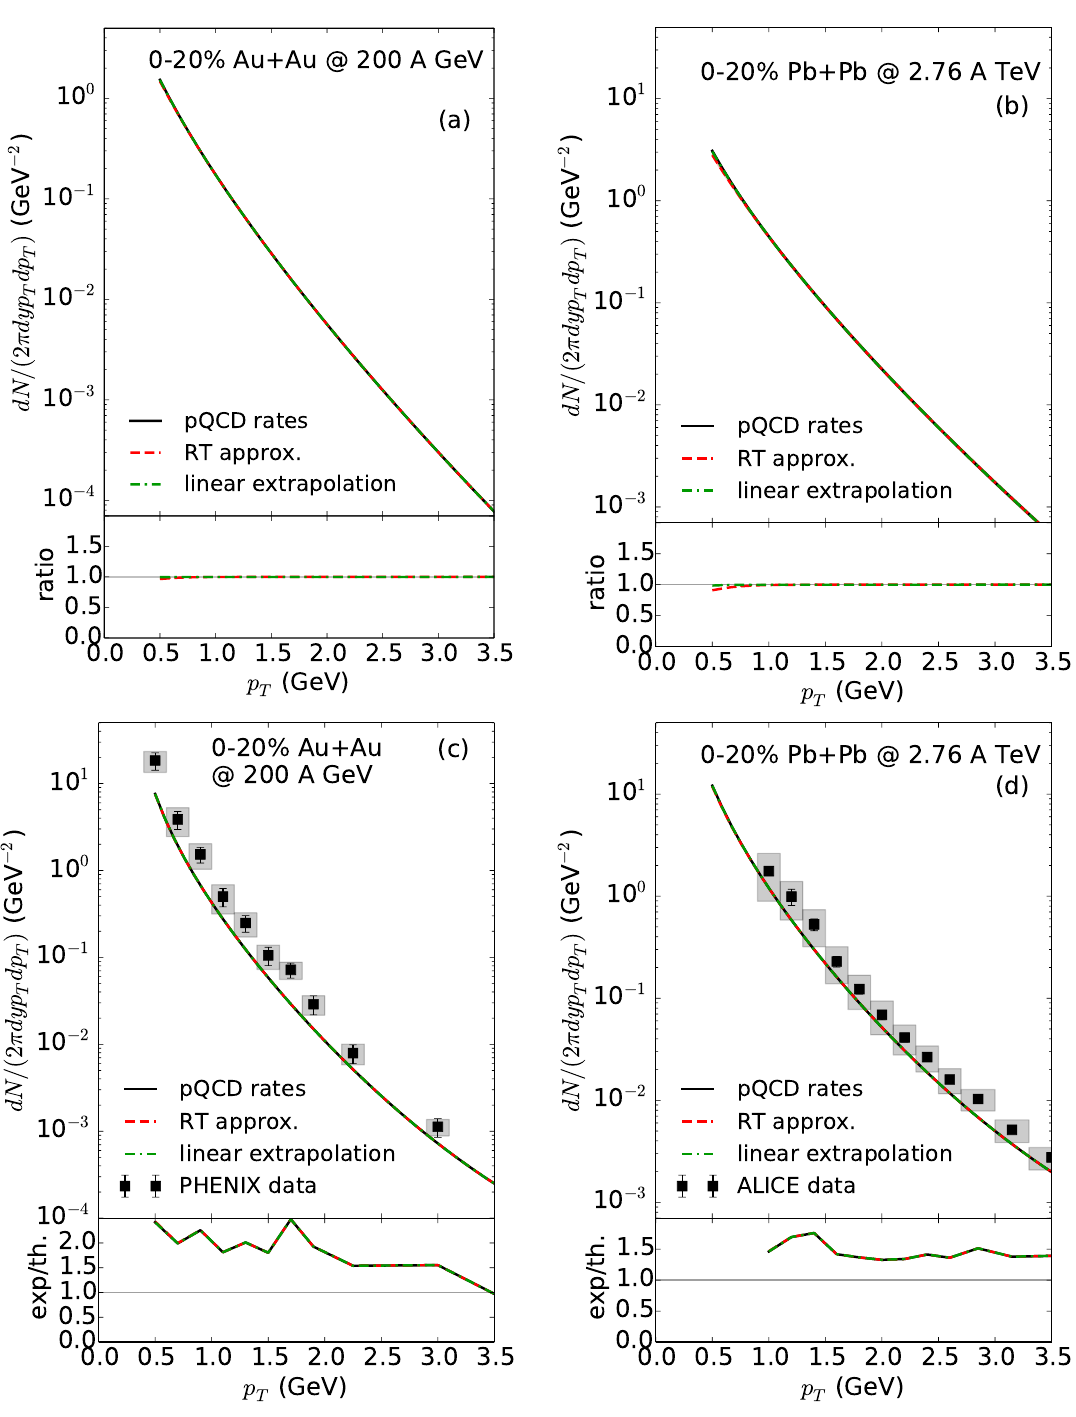
Figure 13 . QGP-photon (upper plots) and Direct-photon (lower plots) spectra led by pQCD rates with di(cid:11)erent interpolations in low energy. Black curves here denote the original results without interpolation.